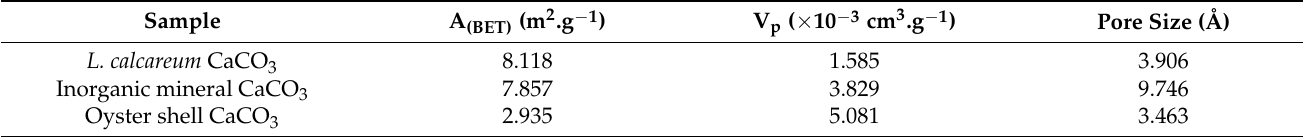
Table 2. Surface area, volume and pore size of Lithotthamnium calcareum , inorganic mineral and oyster shell CaCO 3 samples.